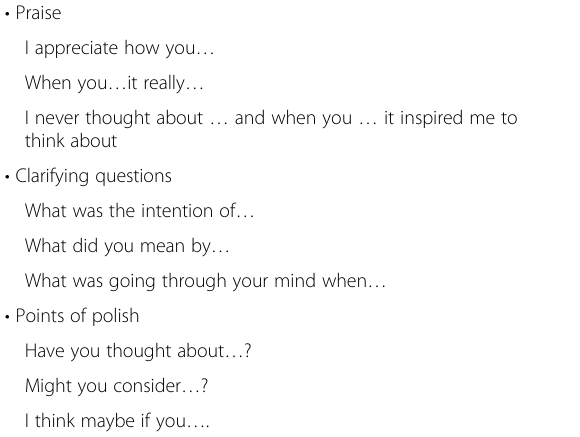
Table 1 Praise-Question-Polish